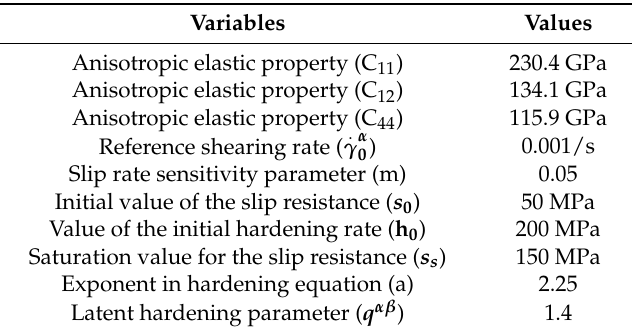
Table 2. Single crystal parameters fitted for model